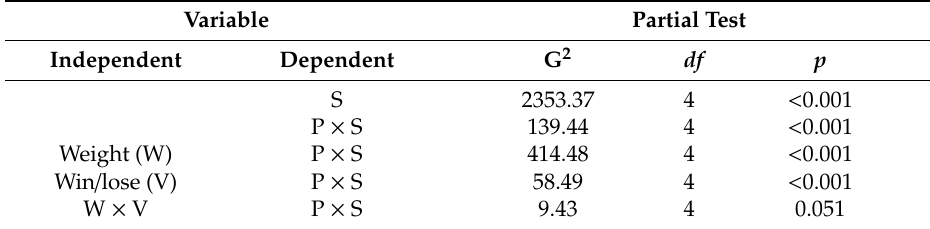
Table 4. ANOVA-like table for partial association G 2 , with (P × S) being treated as dependent measures.